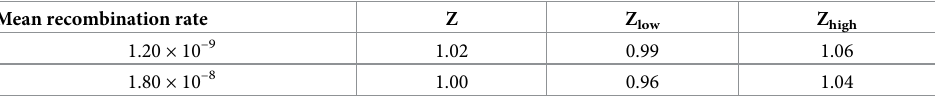
Table 2. Testing for the influence of biased gene conversion I. Estimates of Z for data split by median recombina- tion rate. Code to extract and analyse the data can be found at https://github.com/vivaksoni/test_for_balancing_ selection.